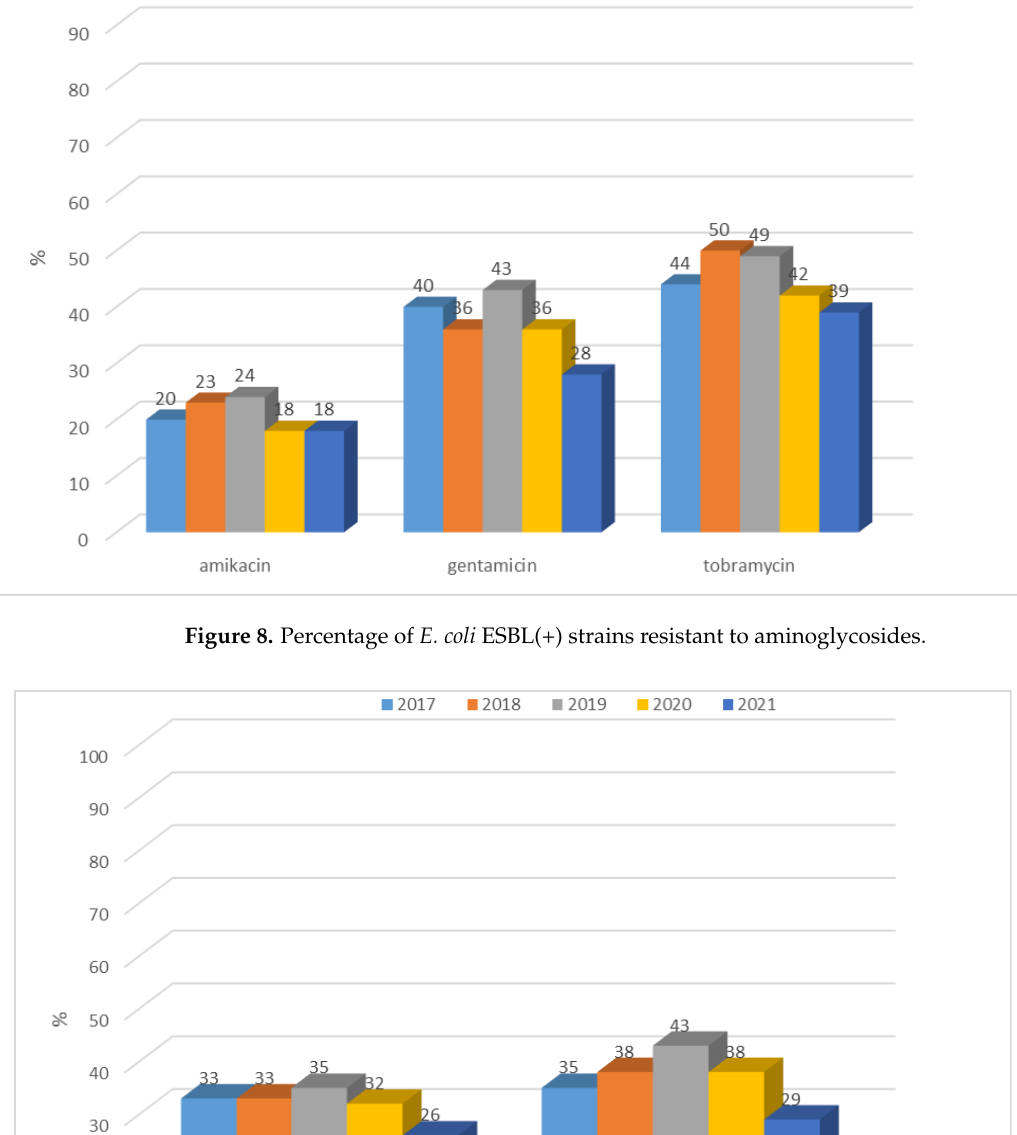
Figure 7. Percentage of aminoglycoside-resistant E. coli ESBL(−) strains.